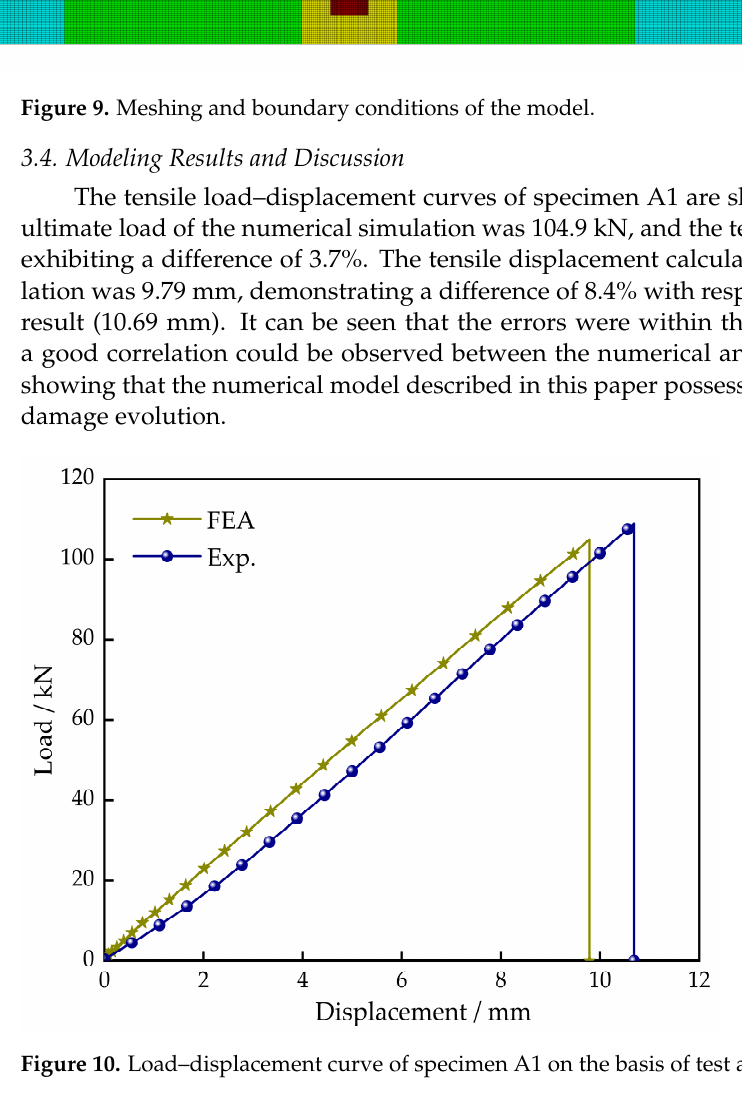
Figure 11. Matrix tensile failure nephogram.